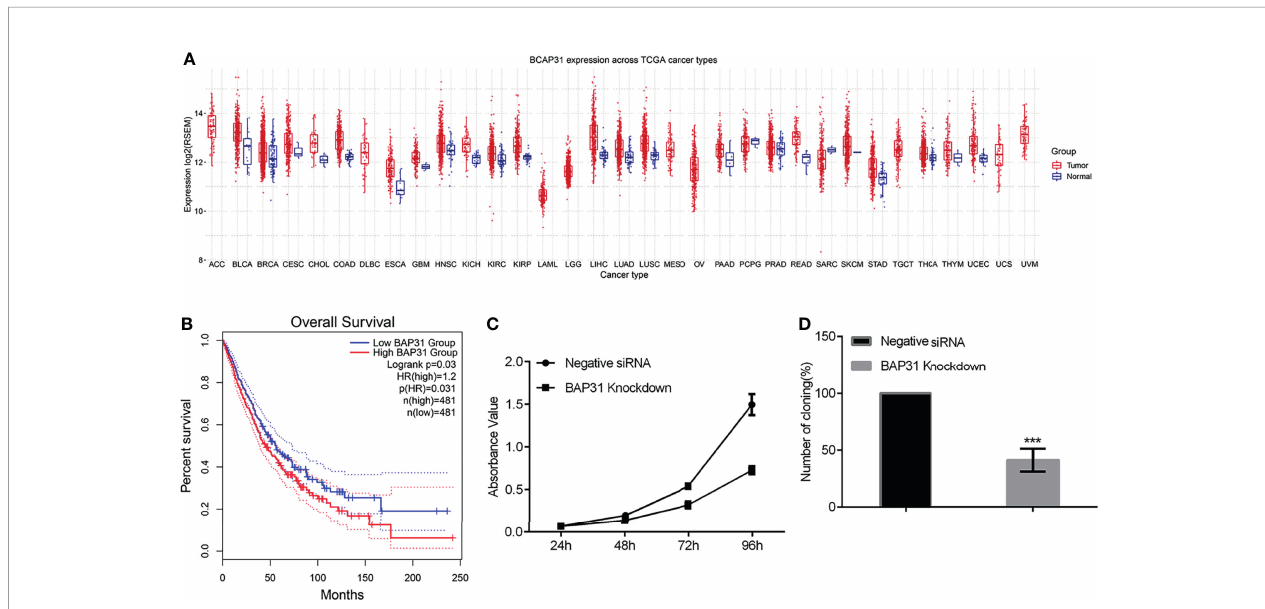
FIGURE 1 | The survival of lung cancer. (A) BAP31 expression in different types of cancer datasets [The Cancer Genome Atlas (TCGA), Taylor). (B) High levels of BAP31 predicted shorter overall survivals in lung cancer. (C) The survival of lung cancer cells A549 treated with BAP31 siRNA was examined by the CCK-8 assay. (D) The colony formation of A549 cells with BAP31 knockdown using siRNA. *** p < 0.001 versus